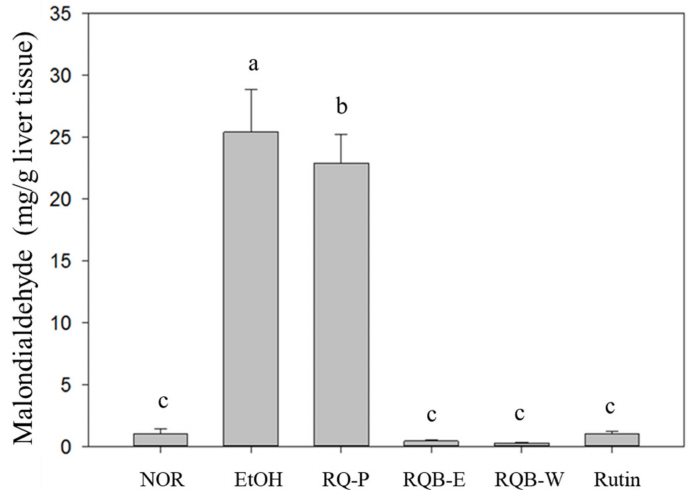
Figure 2. The levels of lipid peroxidation in the liver. The data are presented as the means ± SD ( n = 8). The means followed by the same letter within each column did not differ significantly from each other ( p > 0.05). However, the means followed by different letter expressed significant difference from each other ( p < 0.05). Two groups of mice were fed with normal liquid diet (NOR group) or ethanol liquid diet (EtOH group) without the administration of test materials, respectively. The other mice fed ethanol liquid diet were administrated with red quinoa powder (5.13 g/kg B.W./day, RQ-P group), red quinoa bran ethanol extracts (1.54 g/kg B.W./day, RQB-E group), red quinoa bran water extracts (1.54 g/kg B.W./day, RQB-W group), and rutin (16.4 mg/kg B.W./day, rutin group). TBARS: thiobarbituric acid reactive